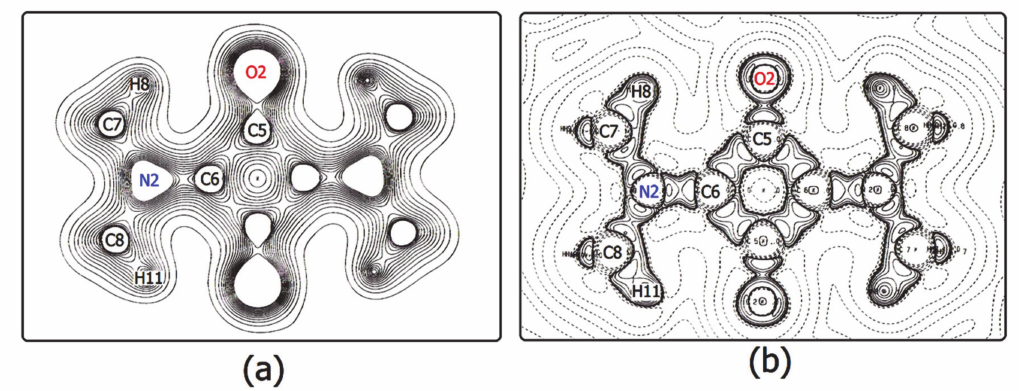
Figure 6. ( a ) Total experimental charge density of SQDH (molecule sq2) at T = 20(1) K in the main molecular plane. Level lines are drawn at steps of 0.01 e Å –3 . ( b ) Distribution of – ∇ 2 ρ ( r ) at variable-step ( ± a · 10 − n e / A 5 , with a = 9.64, 4.82 and 2.20 and n = 0, ± 1, ± 2, ± 3, ± 4 and ± 5). Full lines mark isovalues where electronic charge is locally concentrated, while dashed lines highlight isovalues where charge is locally